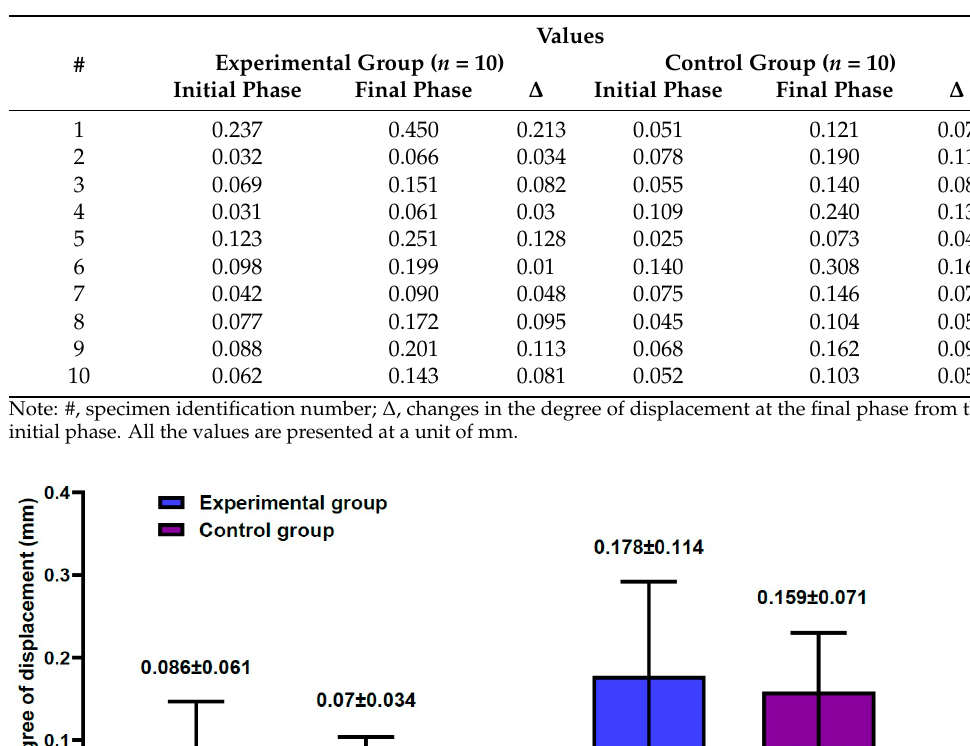
Figure 5. The degree of the displacement of the femoral head implant. Table 1. The degree of displacement at each phase.